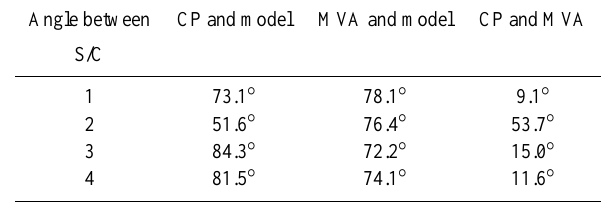
Table 2. Same as Table 1 for the second crossing Angle